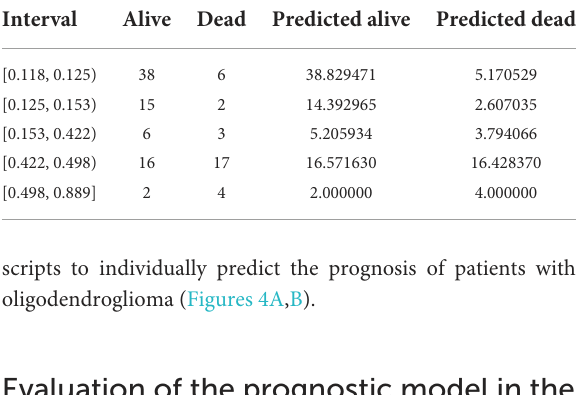
TABLE 2 The predicted value in the Hosmer–Lemeshow test is close to the observed